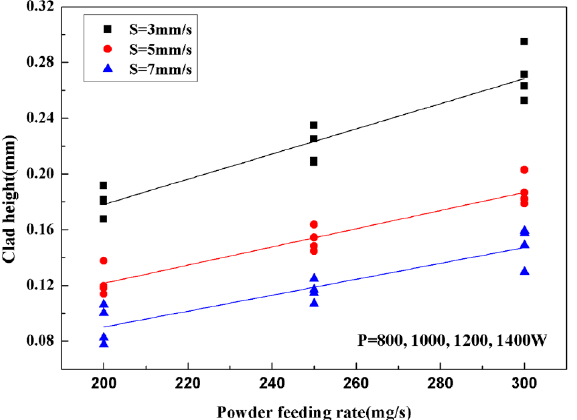
Figure 2. The effect of the main processing parameter on the clad height ( h ).